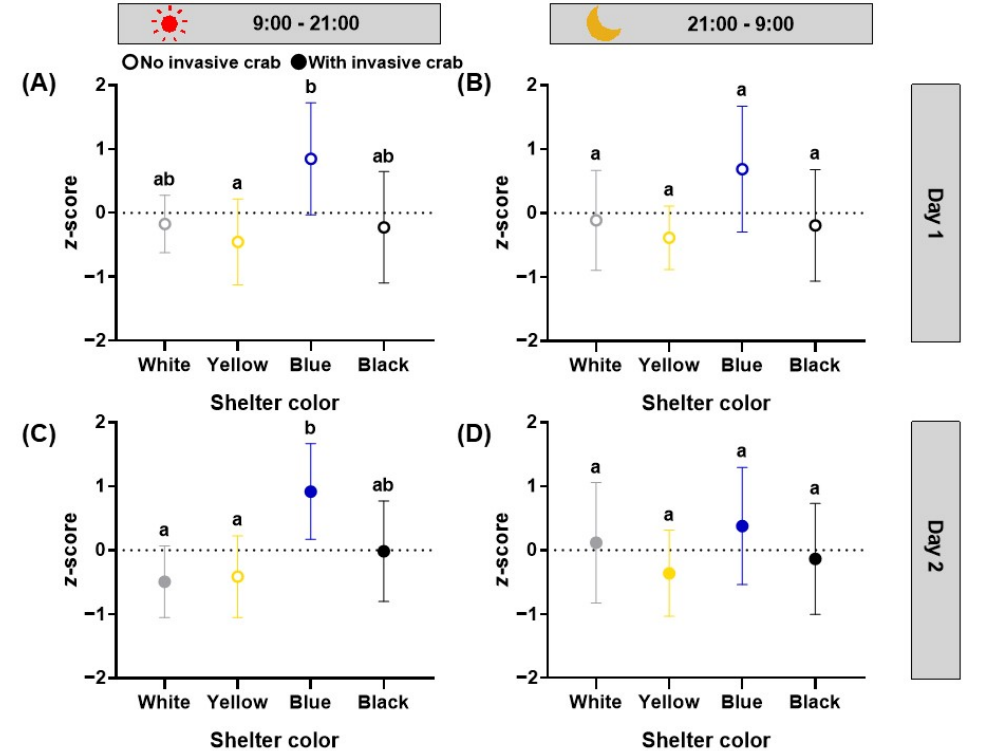
Figure 5. Mean z -scores for the duration of occupation of different colored shelters: the daytime of Day 1 ( A ), the nighttime of Day 1 ( B ), the daytime of Day 2 ( C ), and the nighttime of Day 2 ( D ). Different lowercase letters represent statistically significant differences among z -scores ( p < 0.05).